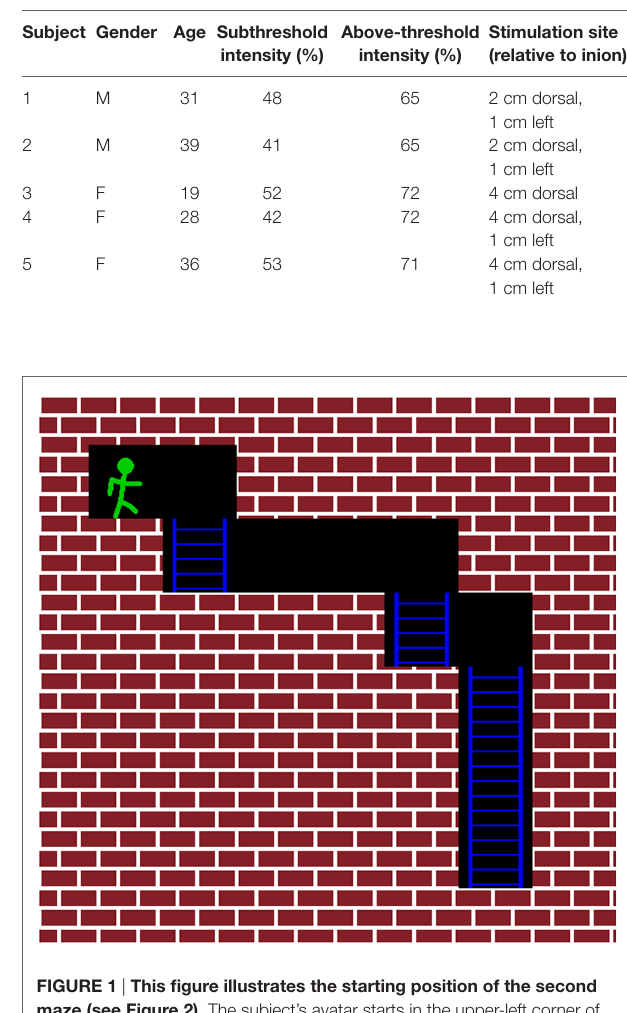
TaBle 1 | subject demographics and stimulation